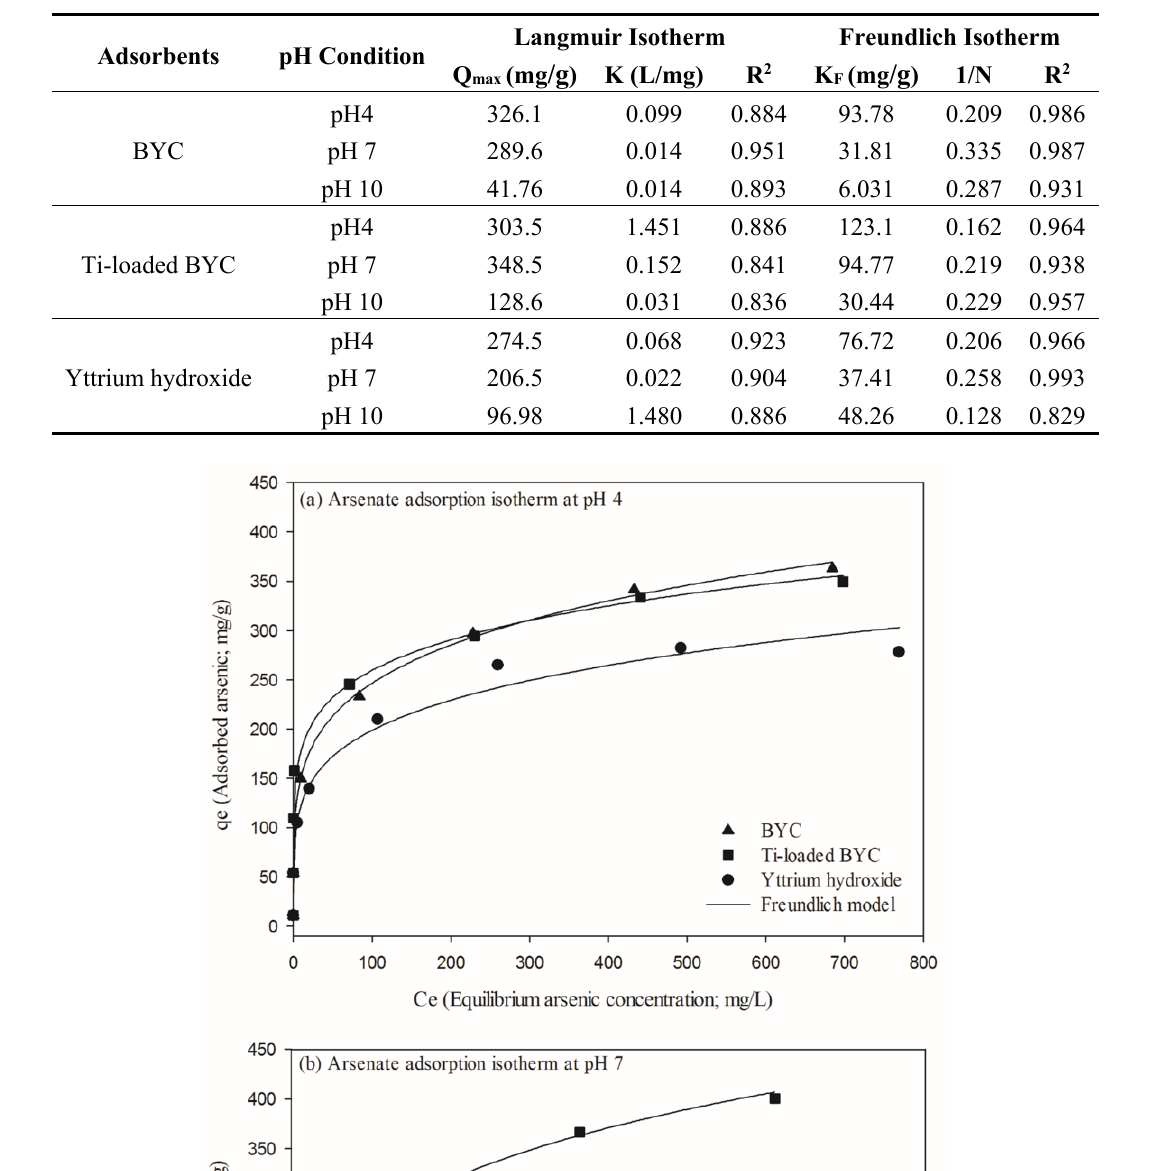
Table 3. Isotherm constant of Langmuir and Freundlich for arsenate adsorption by the BYC, Ti-loaded BYC and yttrium hydroxide.